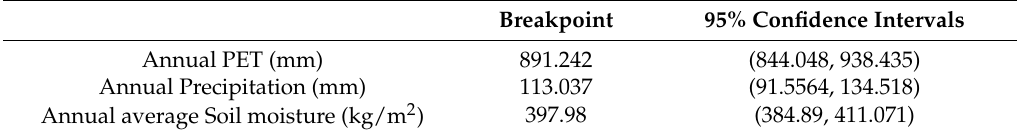
Table 5. Estimates of the breakpoint and approximate 95% confidence intervals.